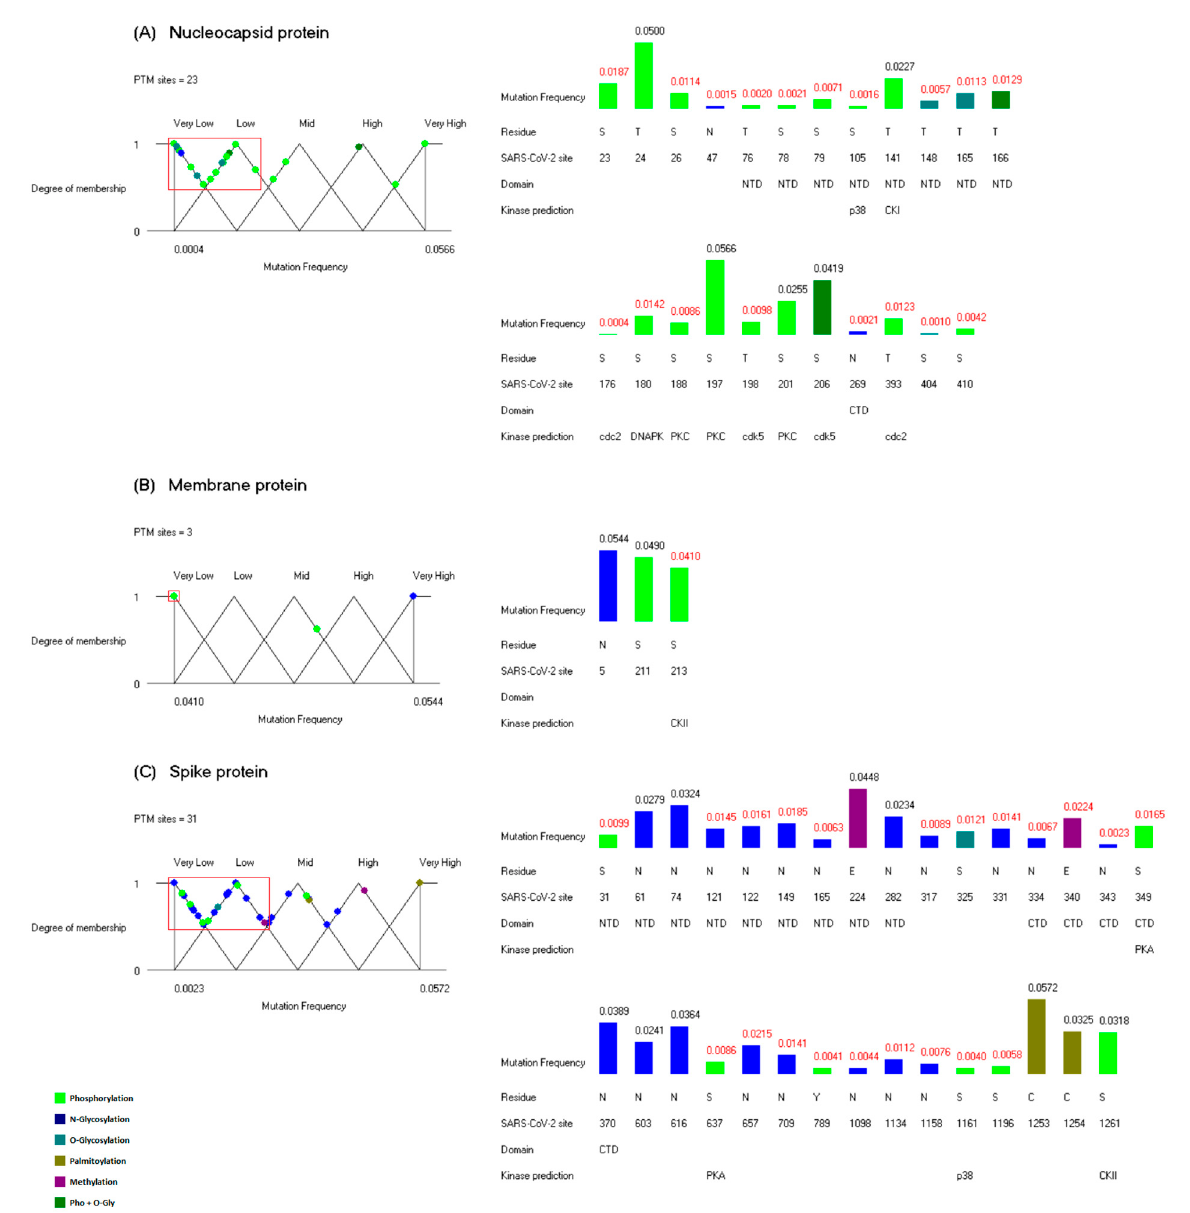
Figure 3. PTM sites with the lowest mutation frequency in the SARS-CoV-2 structural proteins. For each structural protein, ( A ) Nucleocapsid, ( B ) Envelope and ( C ) Spike. A representation of the linguistic variable related to the mutation frequency is shown. The points assigned to the fuzzy sets “Very Low” and “Low” (framed in a red rectangle) were selected as sites of interest. The histograms on the right indicate the mutation frequency of the PTM sites, and the values in red correspond to the PTM sites of interest. In the histograms, the numbers at the top of the bars represent the mutation frequency, and the numbers below indicate the residue, the position in the SARS-CoV-2 sequence, the functional domain in which the residue is located and the kinase prediction if the PTM site corresponds to a phosphorylation. The distinct types of PTMs are represented in different colors as indicated at the bottom left of the Figure.